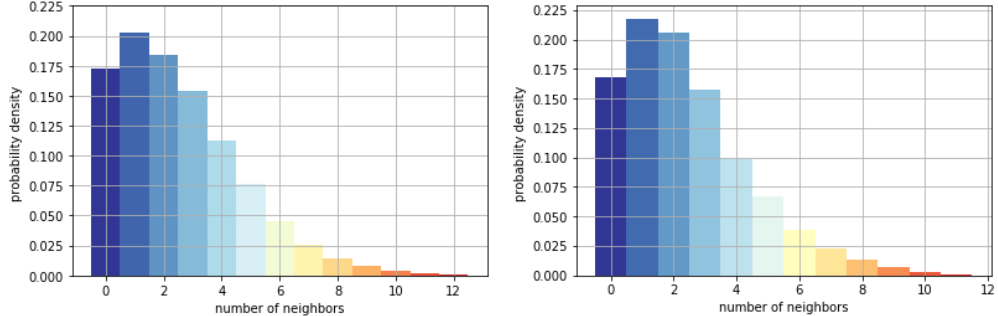
Figure 9. Number of neighbors in the neighborhood of agent: ( left ) person density of training data; ( right ) person density of testing data.